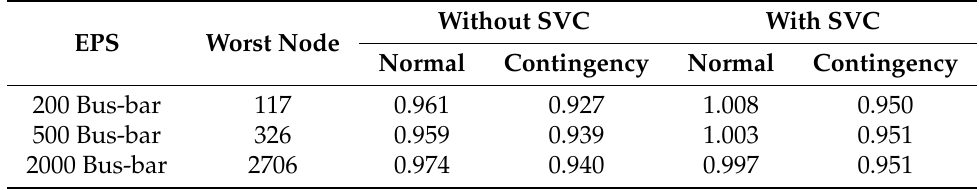
Table 3. Nodes voltages after applying the methodology proposed in large-scale